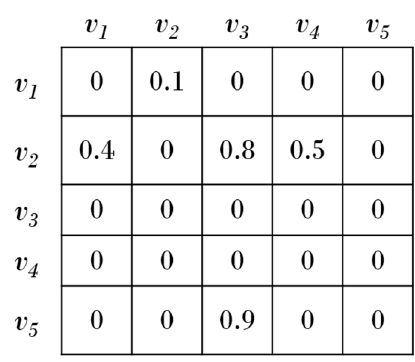
Figure 7. Representation of graph data using a sparse matrix.